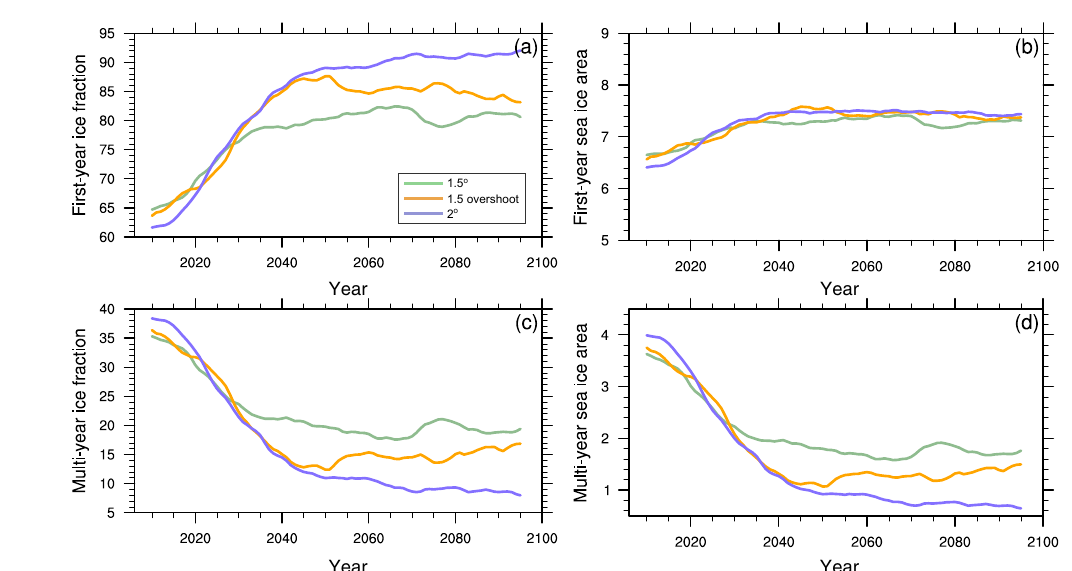
Figure C2. Evolution of the annual 10-year running ensemble mean of first-year and multi-year Arctic sea ice in the low-emission simula- tions. Panel (a) shows the fraction of Arctic sea ice which is less than a year old, (b) shows the sea-ice area which is less than a year old, (c) shows the fraction of sea ice which is greater than a year old and (d) shows the total sea-ice area which is greater than a year old.